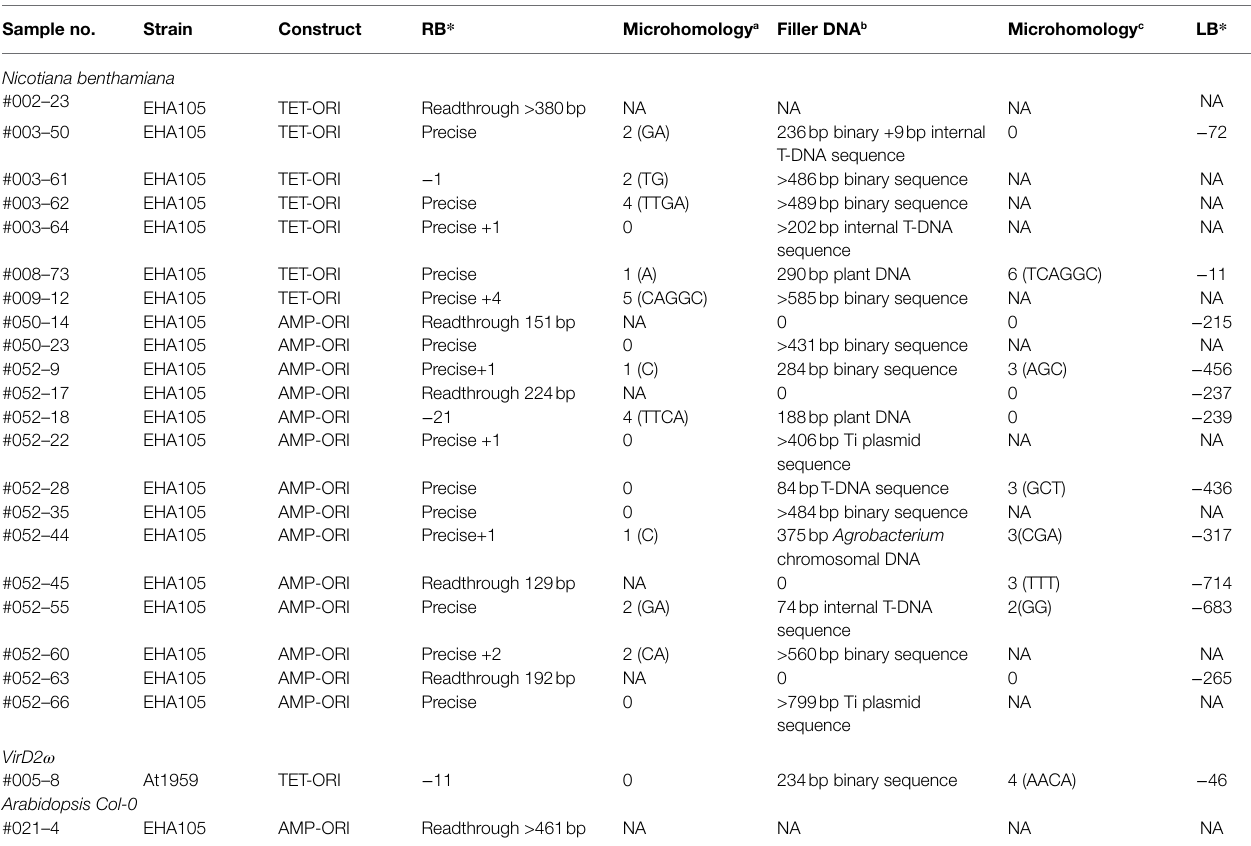
TABLE 4 | Sequenced T-DNA junctions of complex T-circles. Sample